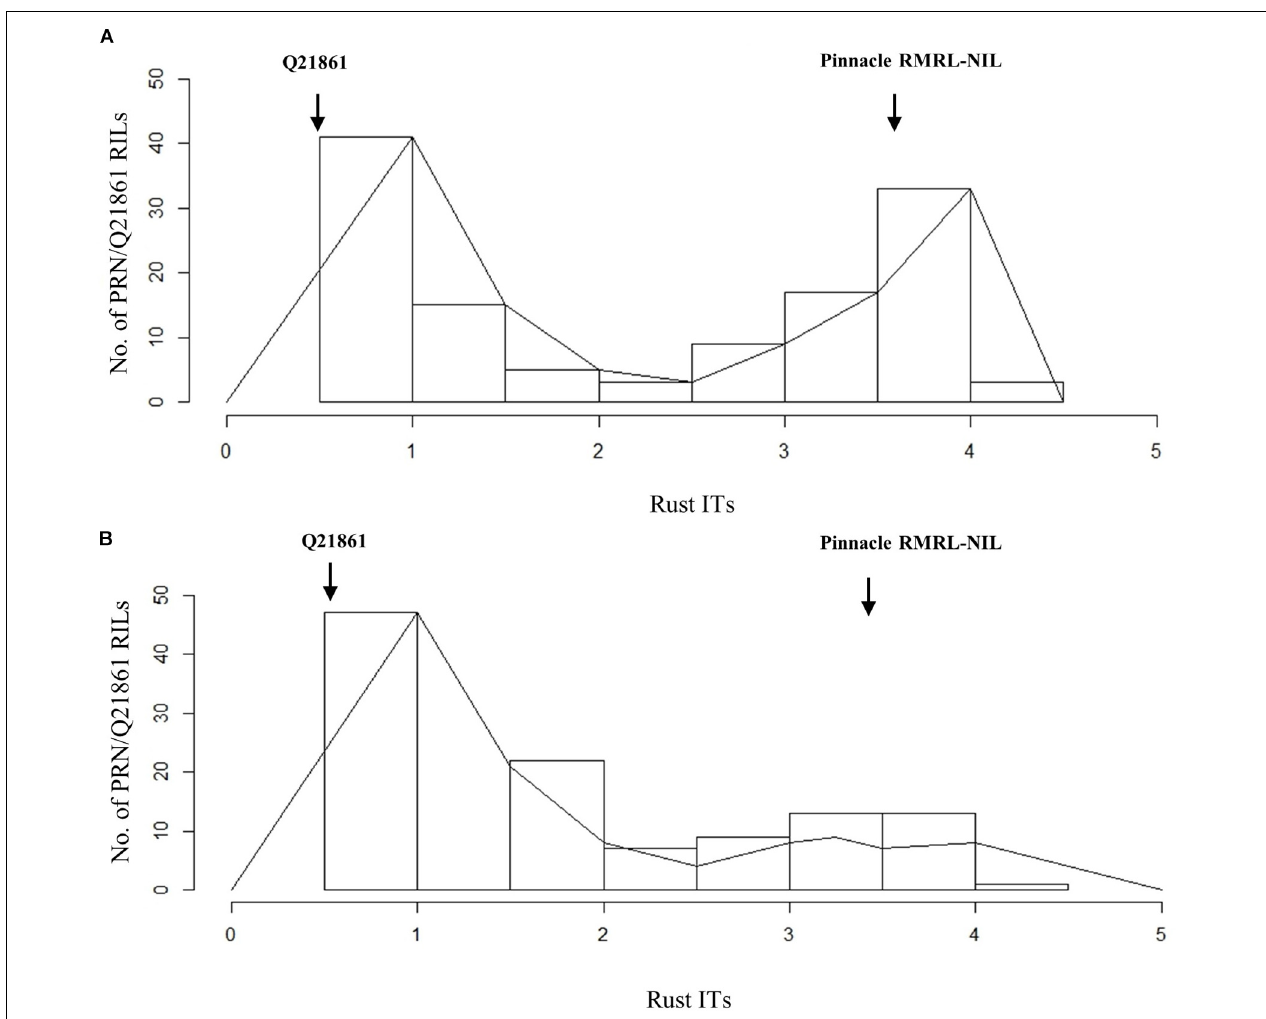
FIGURE 2 | Histogram of stem rust infection types (ITs) exhibited by PRN/Q21861 RIL mapping population upon inoculation with Pgt races (A) QCCJB and (B) HKHJC. The rust ITs are shown on y -axis representing the quantitative scores obtained when using the conversion scale provided by Zhou et al. (2014).